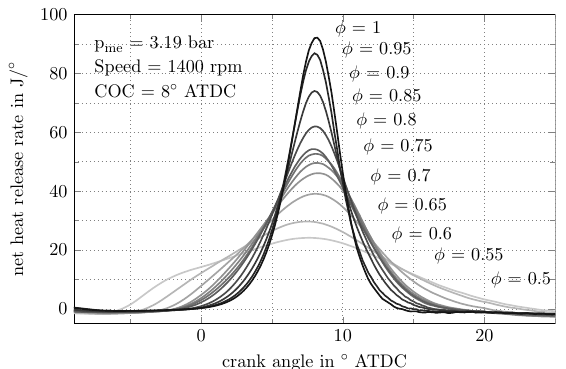
Figure A1. Measured net heat release rate of one sweep of the fuel-to-air equivalence ratio φ . The shown traces are obtained by calculating the mean value of 60 engine cycles.